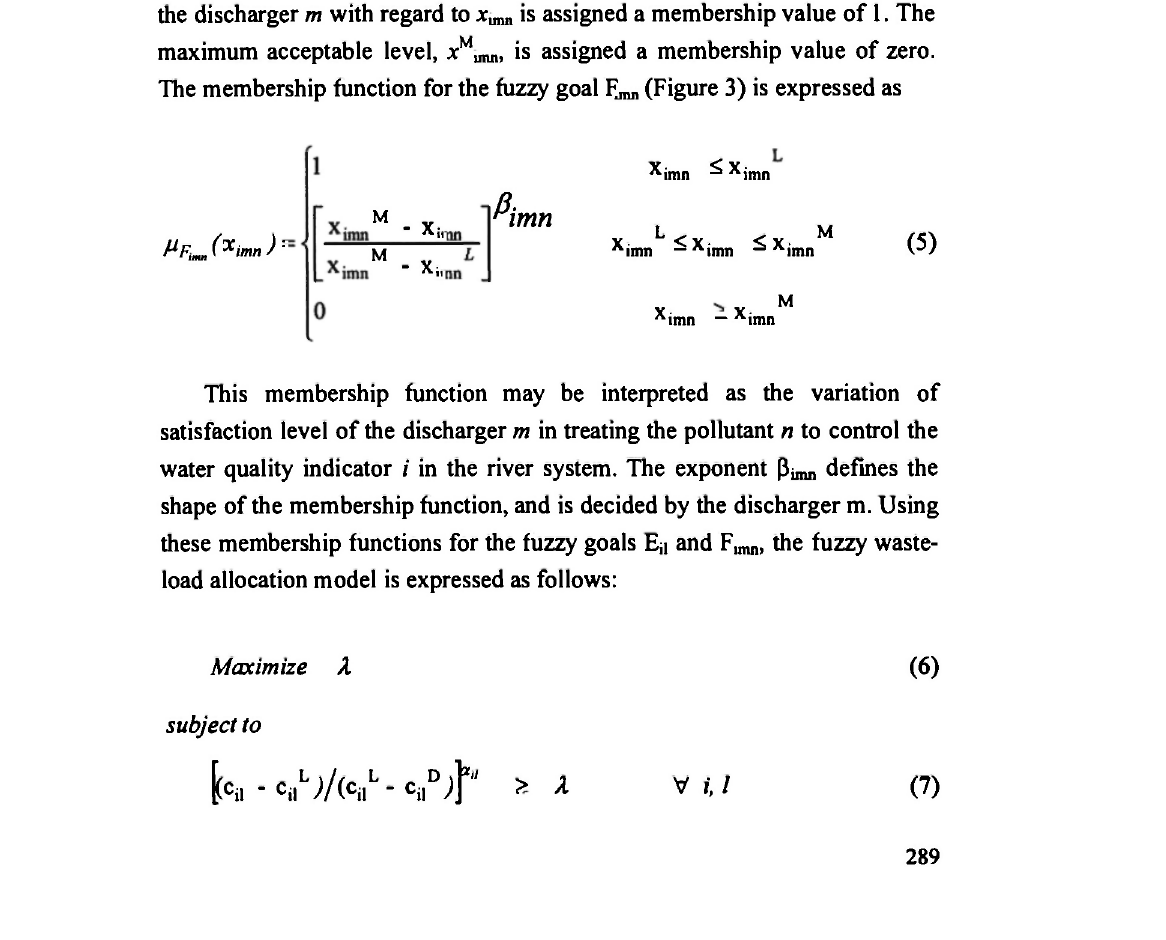
Fig. 3: Membership Function for Goal, F